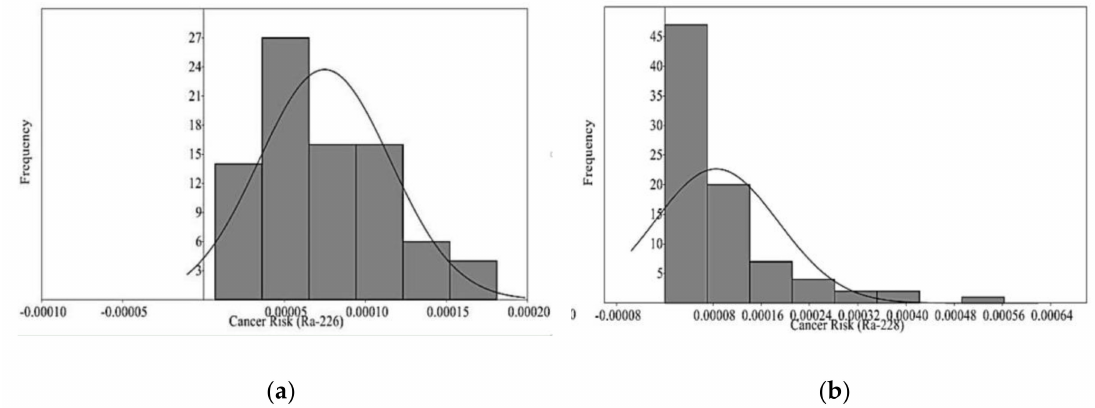
Figure 7. Histogram of the cancer risk results of water consumption for radium-226 ( a ) and radium-228 ( b ) in the study area respectively.